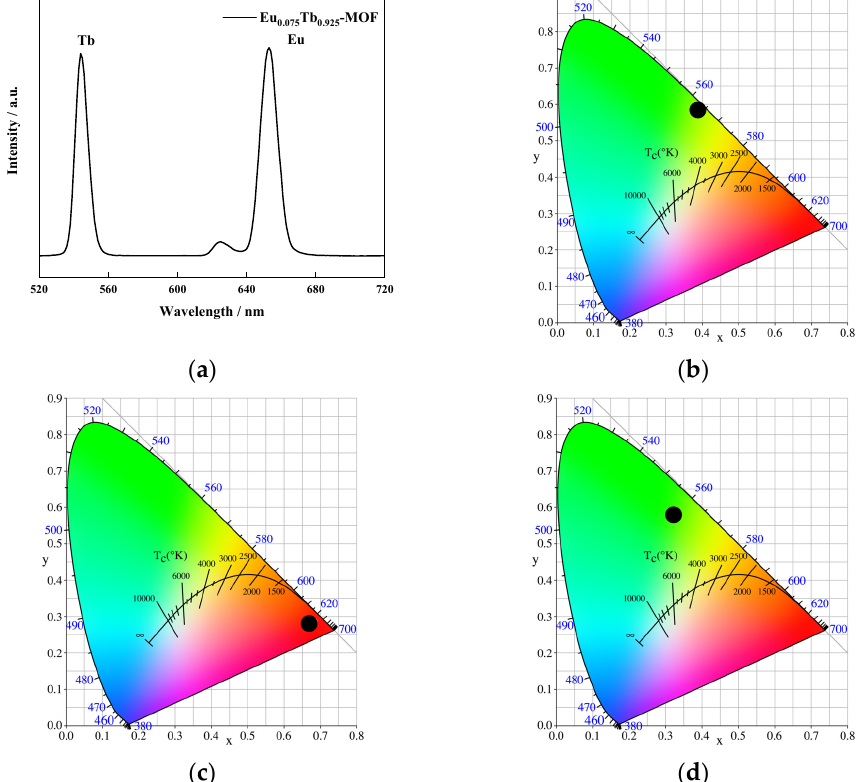
Figure 7. ( a ) Emission spectra of Eu 0.075 Tb 0.925 -MOF, ( b ) CIE of Eu 0.075 Tb 0.925 -MOF, ( c ) CIE of Eu-MOF, and ( d ) CIE of Tb-MOF.